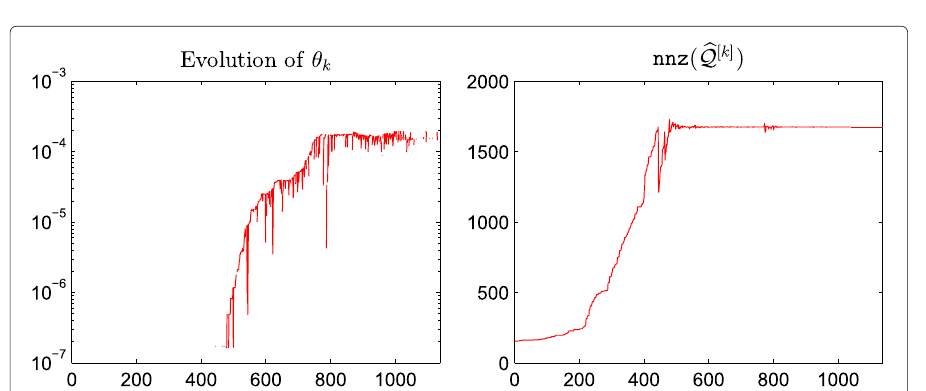
(cid:5) (cid:4) . Enron: behaviour of θ k and the number of nonzerso in Q [ k ] with respect Q [ k ]